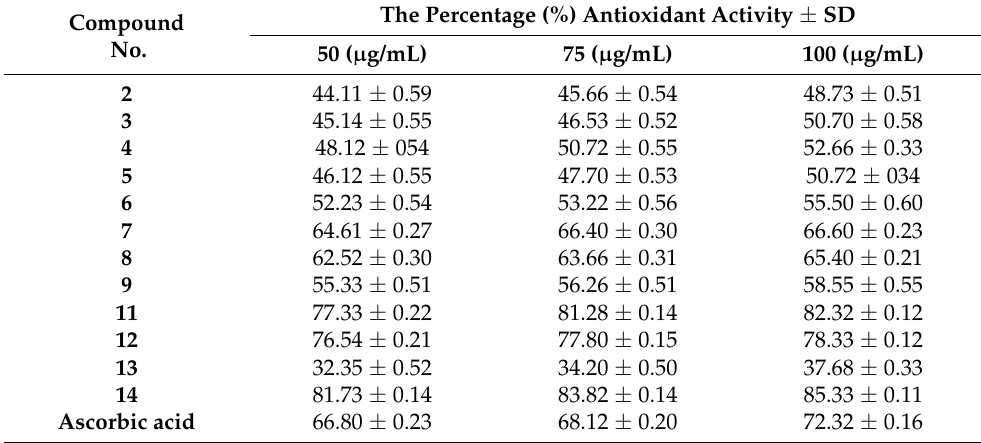
Table 2. The percentage (%) antioxidant activity of β -carotenoid based on its radical adducts with free radicals from linoleic acid for the compounds 2 – 14 relative to the standard antioxidant ascorbic acid.